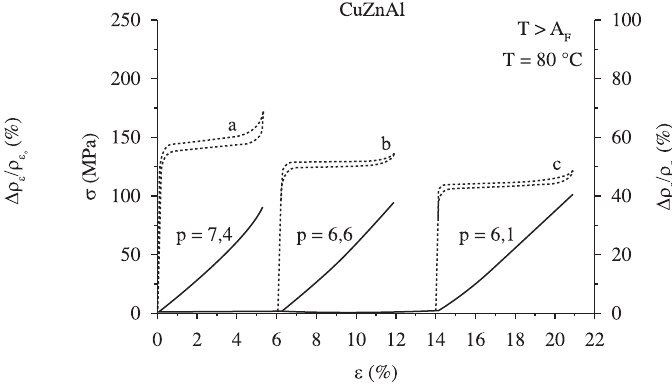
Figure 5. Electro-mechanical curves of successive martensitic transformation in the CZA3 sample.